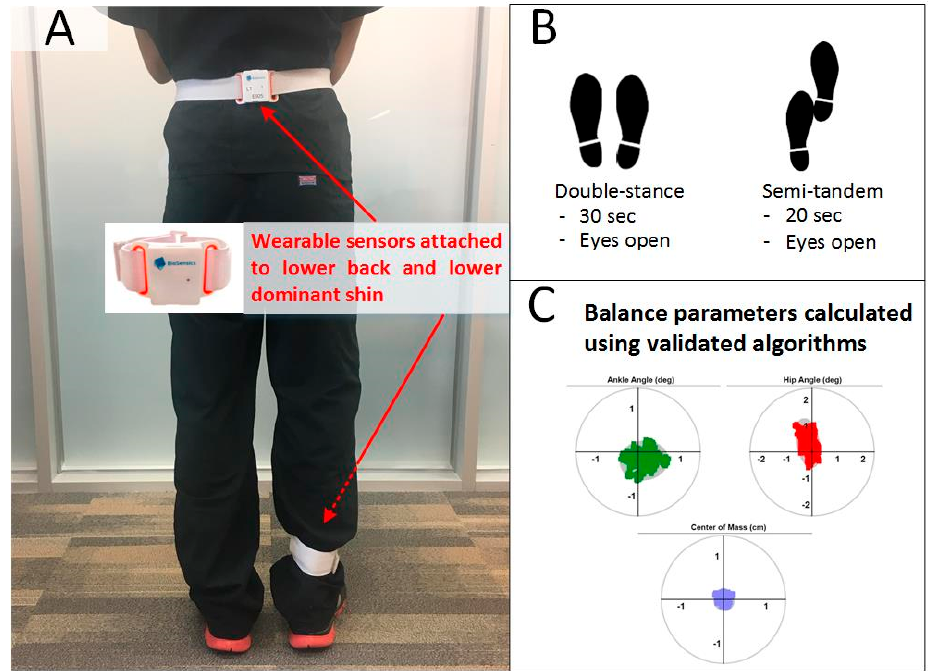
Figure 2. An Illustration of balance test. ( A ) Two wearable inertial sensors were attached to lower back and lower dominant shin. ( B ) Double-stance for 30 s and semi-tandem for 20 s under eyes open condition were performed. ( C ) Using validated algorithms balance parameters of interest, including ankle sway (unit: deg 2 ), hip sway (unit: deg 2 ), center of mass sway (unit: cm 2 ), and normalized center of mass sway to height (unit: cm 2 /height) were calculated.